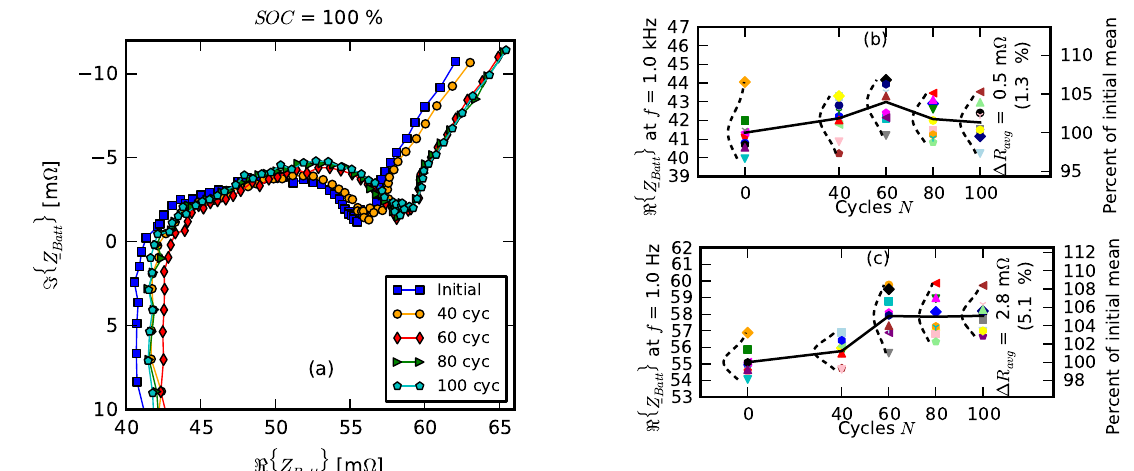
Figure 6. Impedance changes during pack cell aging. ( a ) average impedance spectra; ( b ) real part change for individual cells at f = 1 kHz; ( c ) real part change for individual cells at f = 1 Hz.